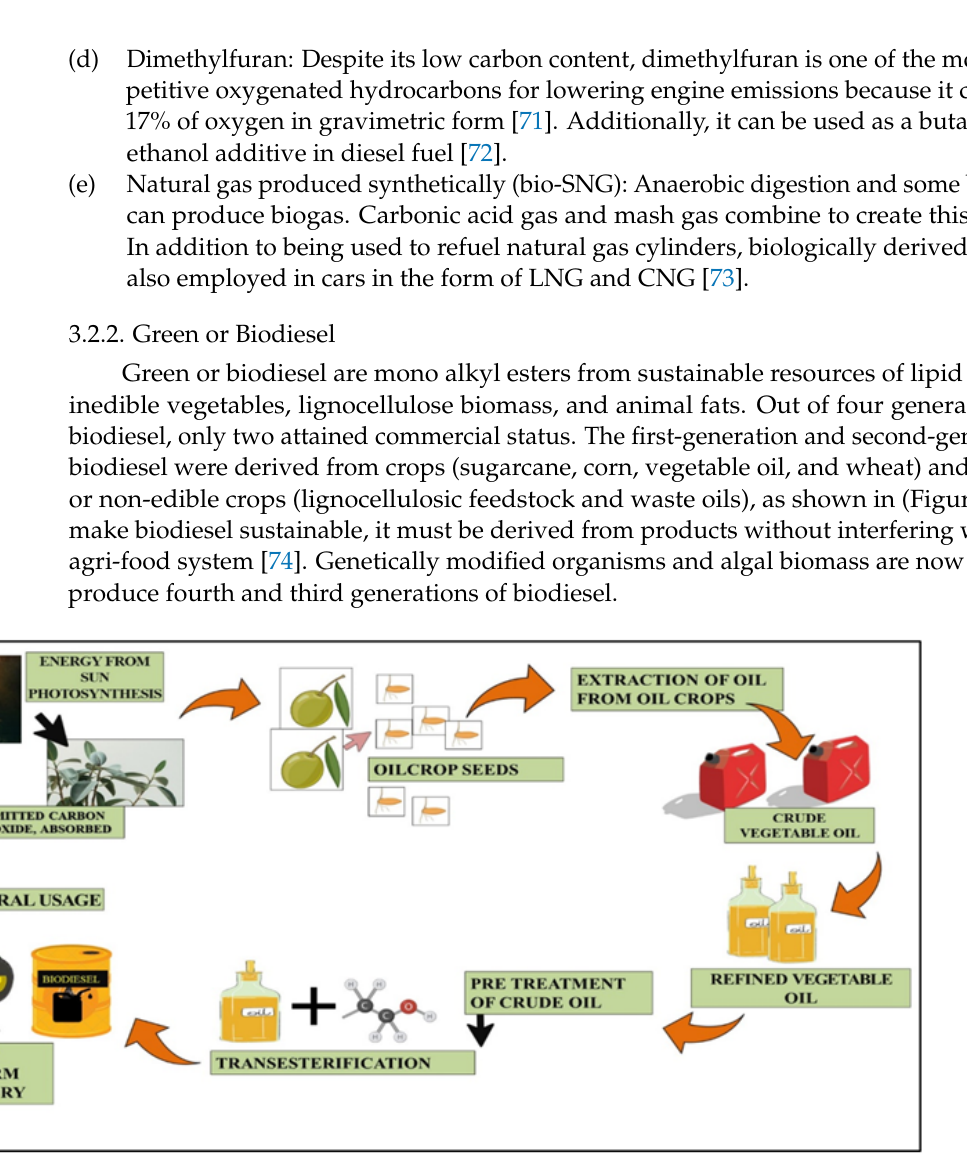
Figure 3. Production of biodiesel and its usage for agriculture purposes.